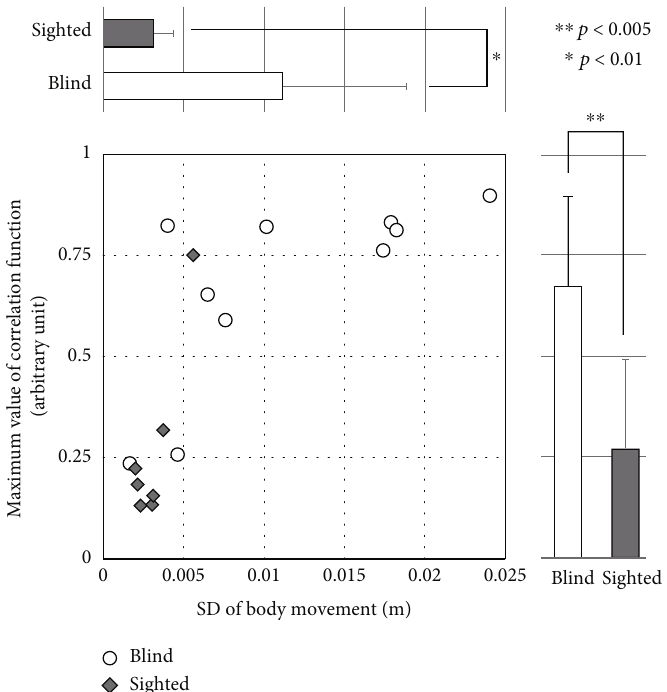
Figure 4: Distribution of the “ SDs of the body movements ” and the “ maximum value of the correlation function. ” The horizontal bar graph above the distribution graph illustrates the average and standard deviations of “ the SDs of body movements. ” The vertical bar graph at right of the distribution graph shows the average and standard deviations of “ the maximum correlation functions.